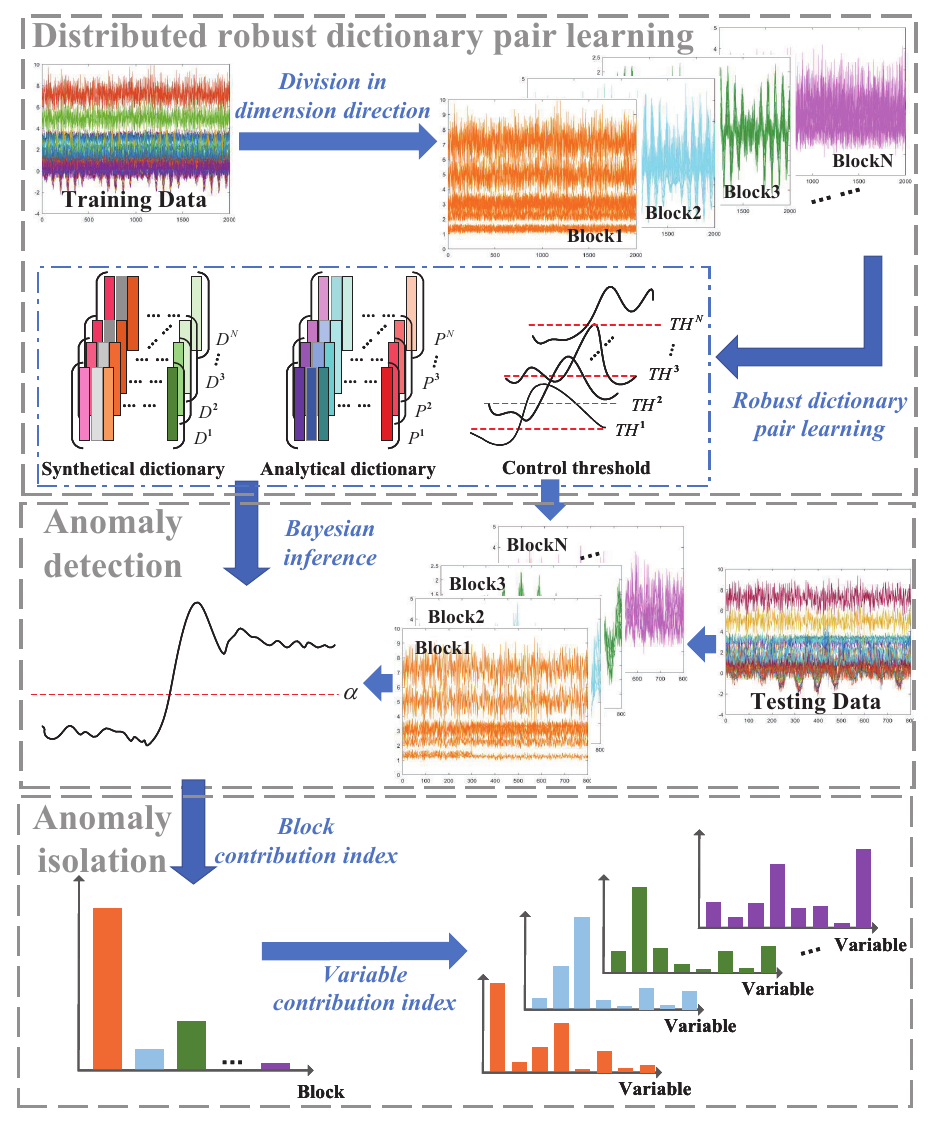
Figure 2. Schematic diagram of the process monitoring method based on distributed robust dictionary pair